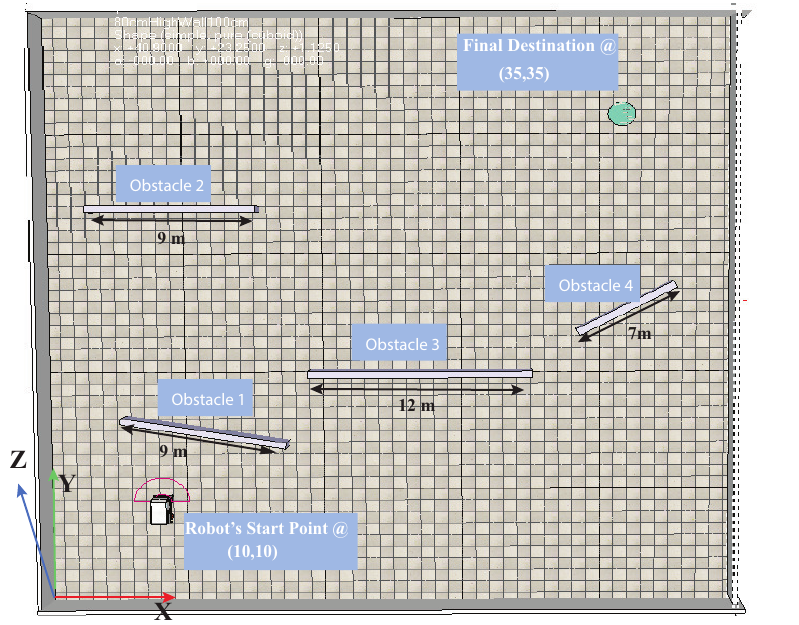
Figure 2. Simulation